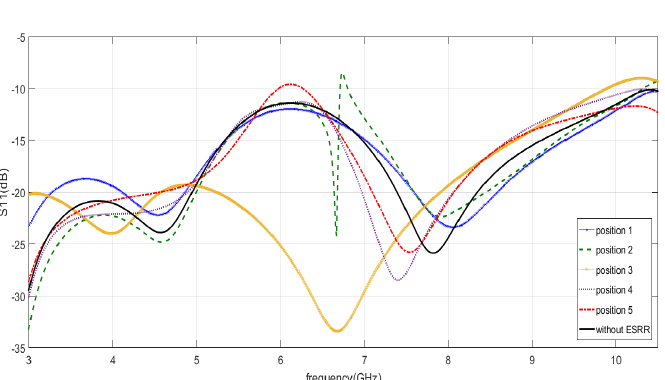
Figure 7: The UWB antenna with two rotated ESRRs with different rotational angles θ , θ 1